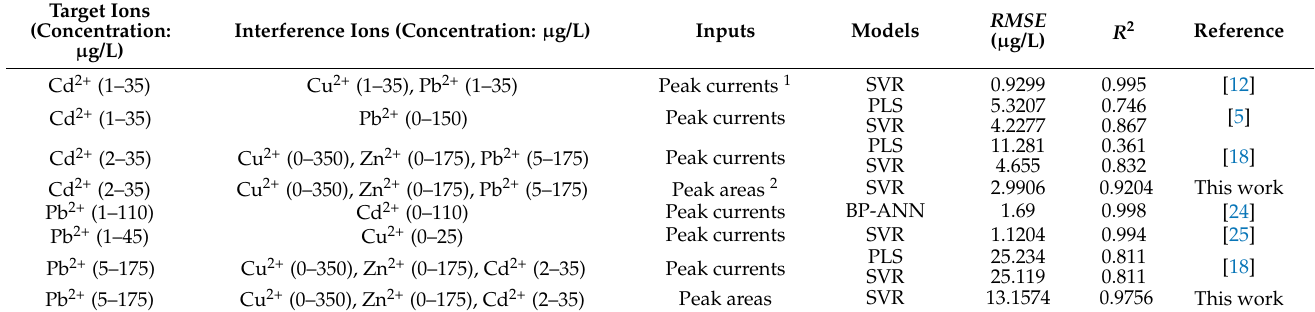
Table 1. Comparison of the detection accuracy of various inputs and machine learning models for Cd 2+ and/or Pb 2+ under the interference of non-target